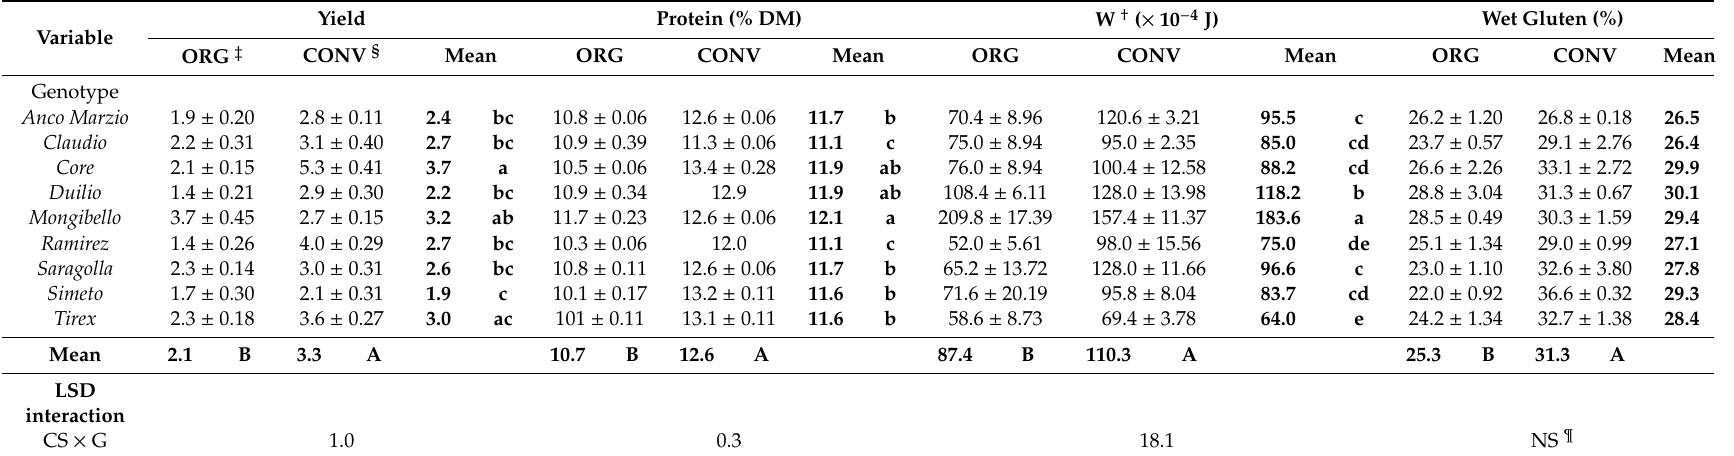
Table 3. Yield (t ha − 1 at 13% moisture) and quality parameters as a ff ected by ‘cropping system (CS) × genotype (G)’ interaction. Di ff erent letters (a–e or A, B) within each main factor indicate significant di ff erences (LSD test, p ≤ 0.05). All data are expressed as mean ± standard